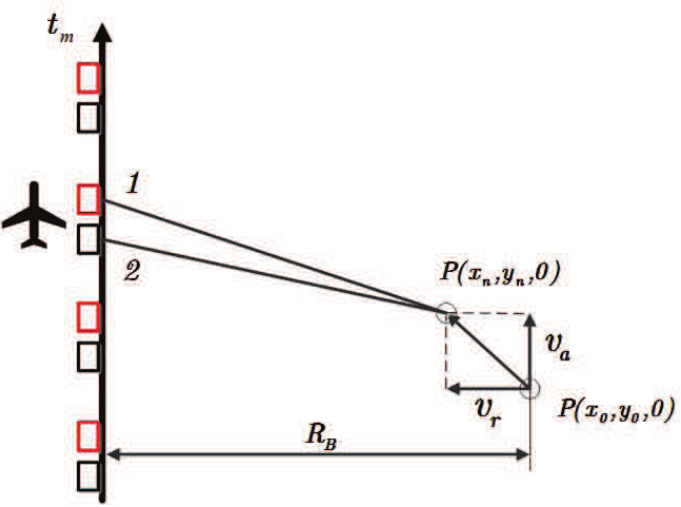
Figure 2. Slant range history geometry of the moving target.